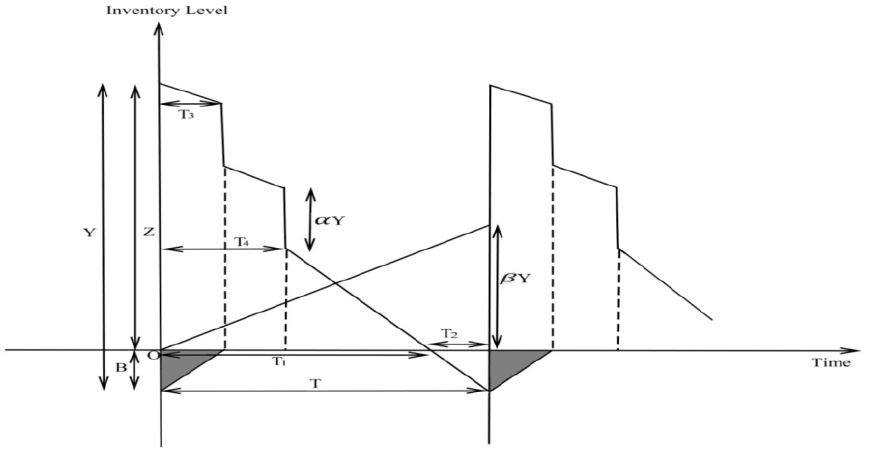
Figure 7. Buyer’s inventory representation for time 𝑇 .